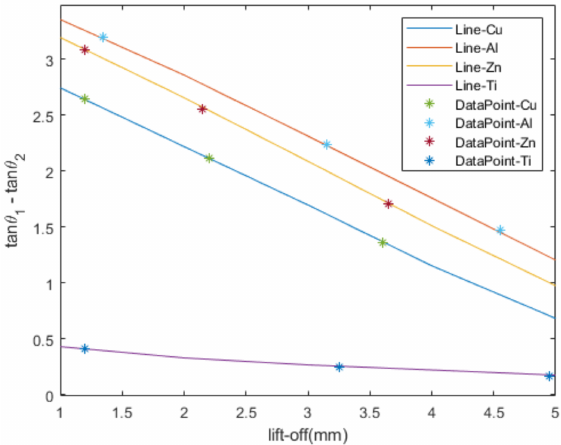
Figure 8. Experimental verification